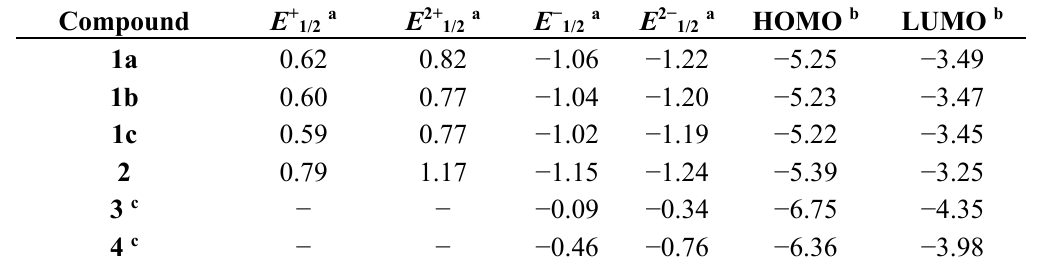
Table 3. Summary of half-wave redox potentials, HOMO and LUMO energy levels for perylene bisimide